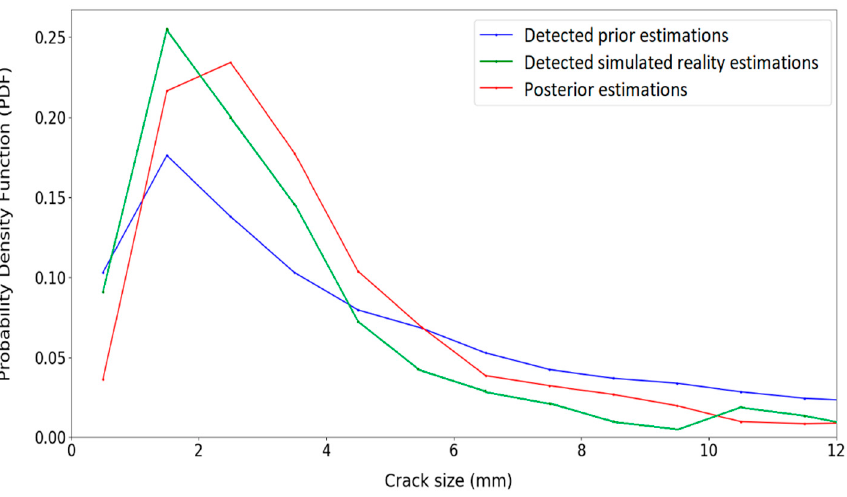
Figure 14. Crack size distributions before and after updating